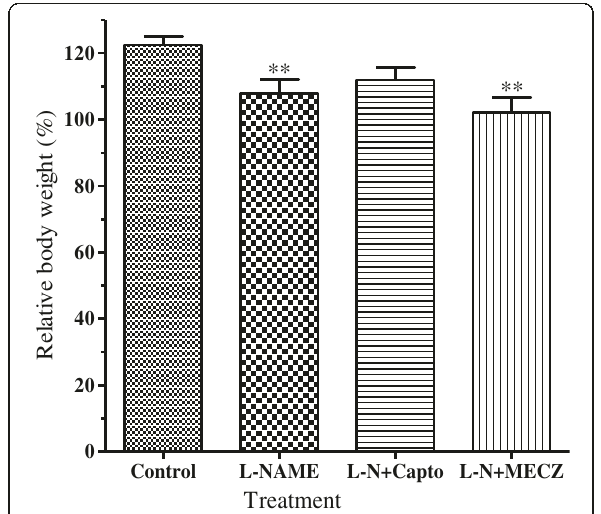
Figure 3 Effects of chronic treatment on the rat relative body weight. n=5; **p<0.01 significantly different compared to the